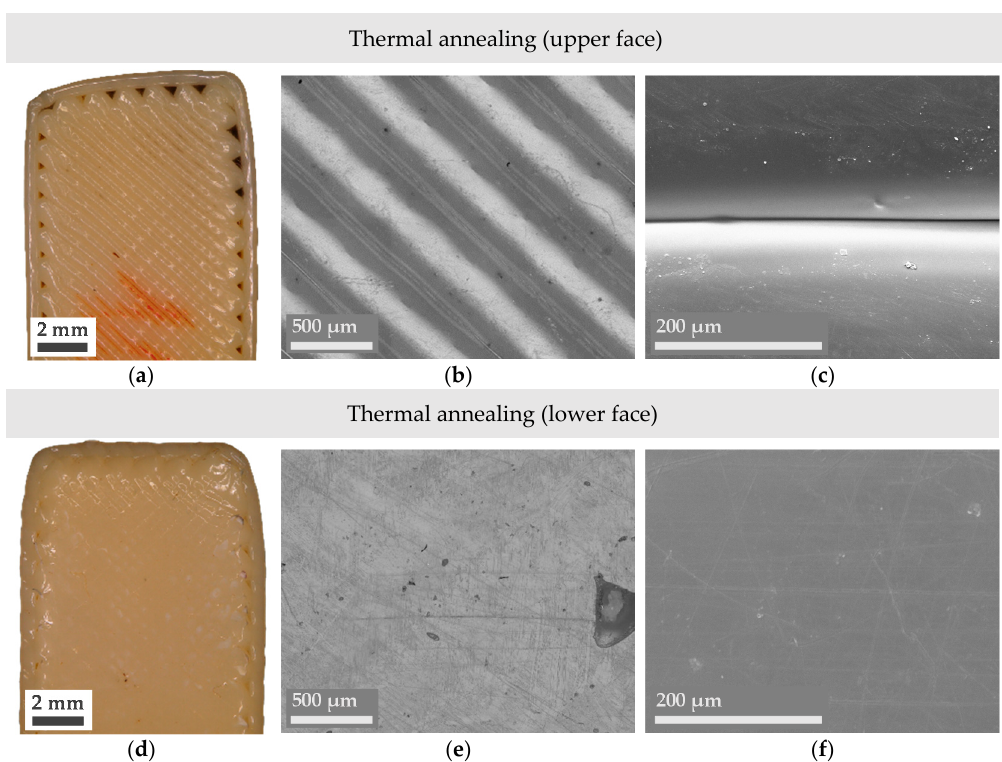
Figure 4. Digital microscope ( a , b , d , e ) and SEM micrographs ( c , f ) of the thermally treated Ultem